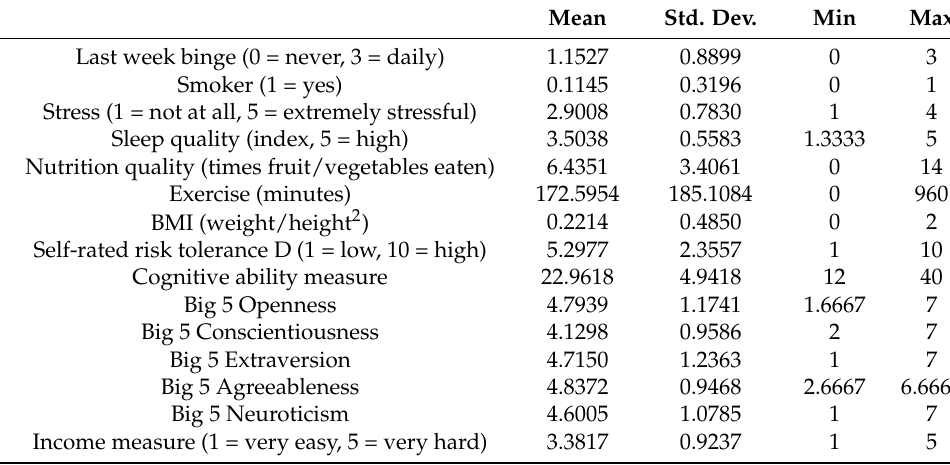
Table 1. Basic descriptive